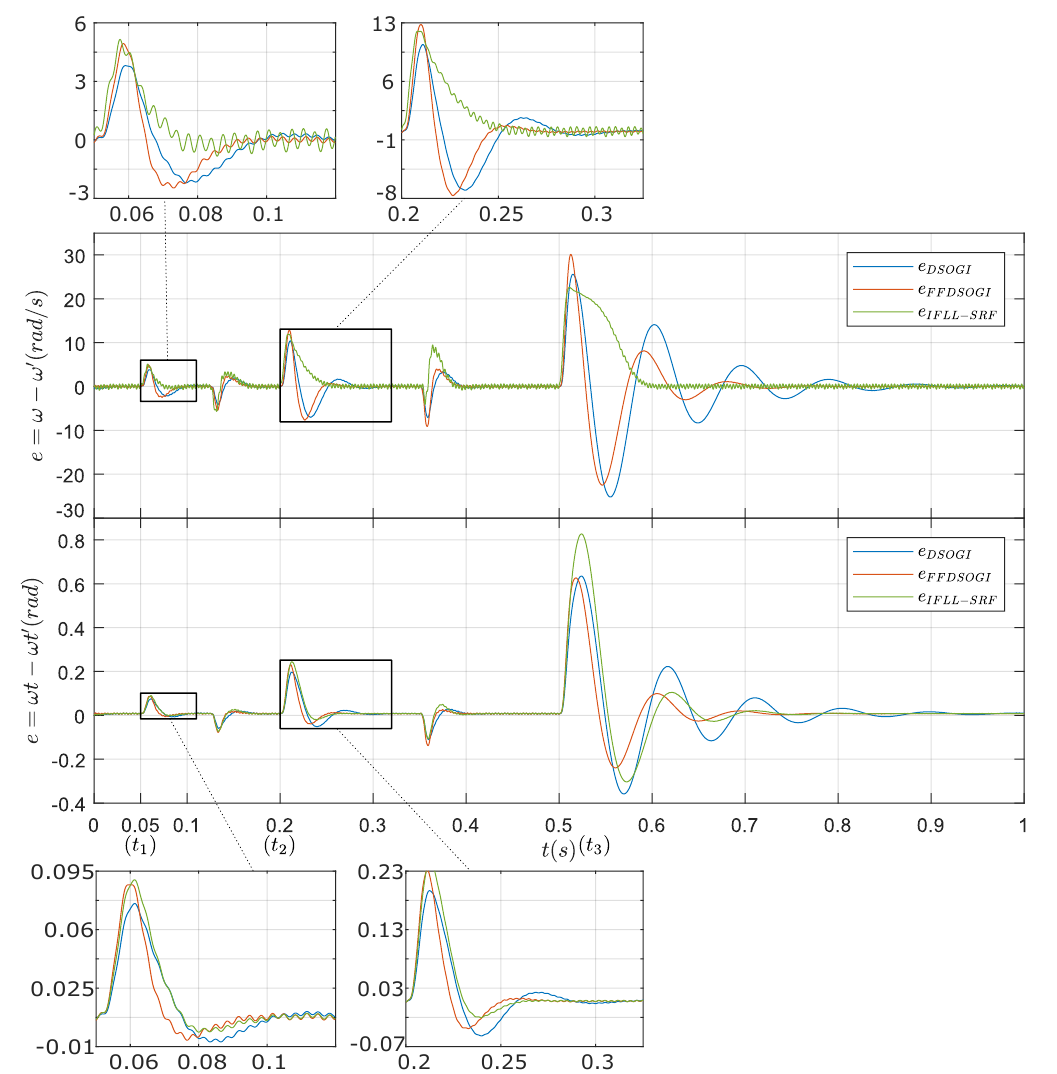
Figure 16. Estimated frequency and phase errors for the different methods during test #3. Table 11. Results summary obtained for test #3- voltage